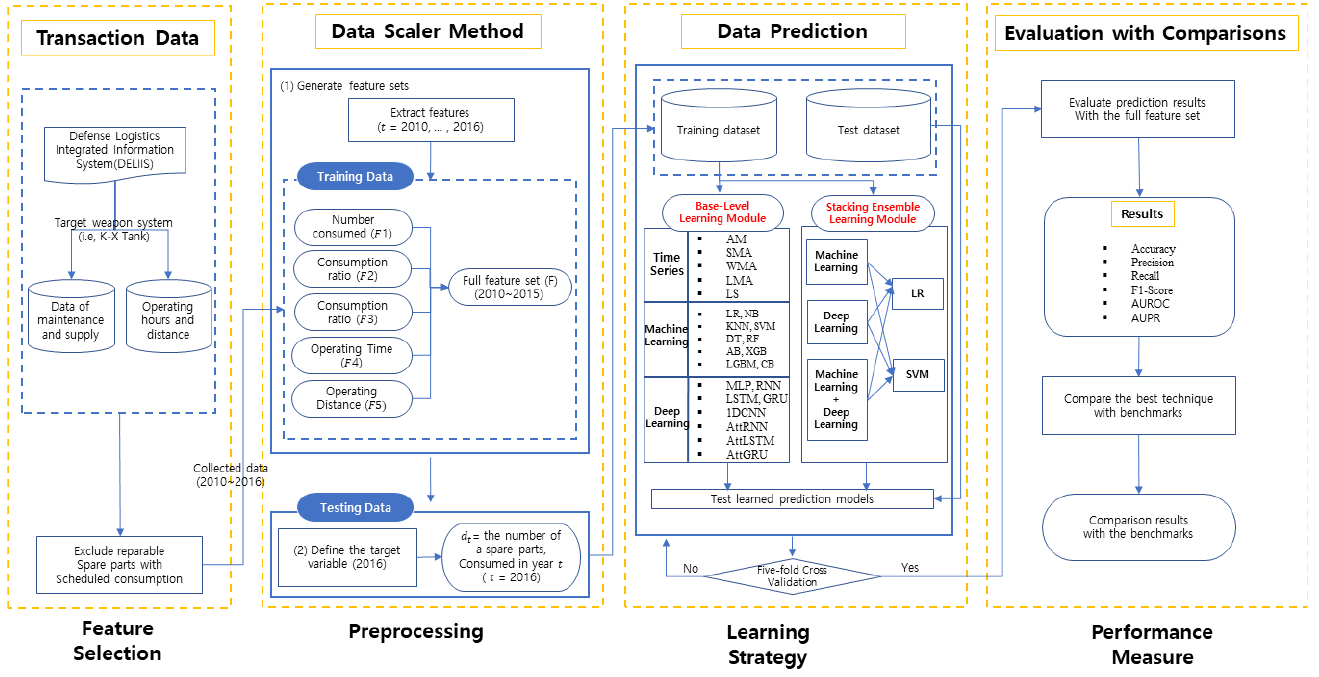
Figure 2. Overview of demand forecasting mechanism based on the stacked generation.